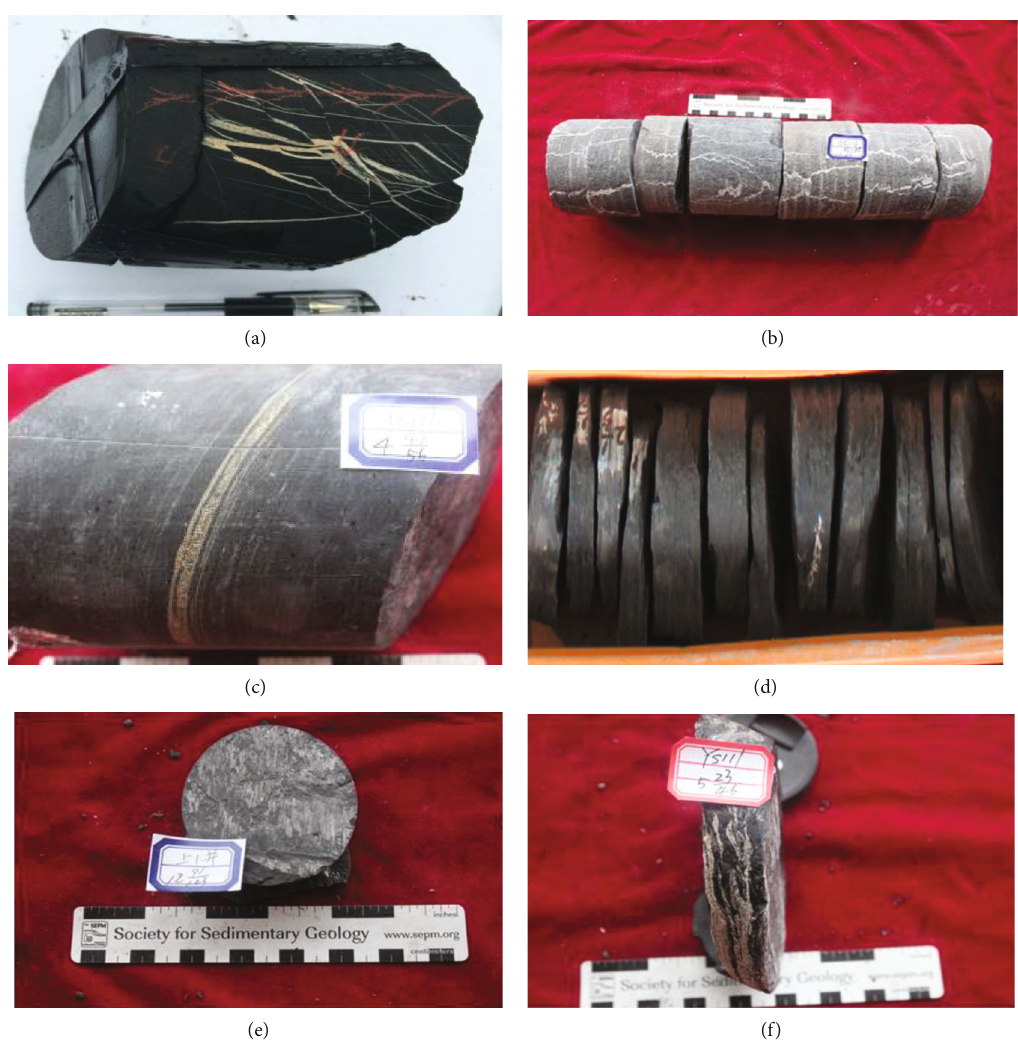
Figure 3: Characteristics of the shale fractures in the Longmaxi Formation. (a) High-angle fractures fi lled with calcite; (b) high-angle fractures fi lled with calcite; (c) un fi lled high-angle fractures; (d) lamellation; (e) diagenetic shrinkage fractures; and (f) diagenetic shrinkage fractures.